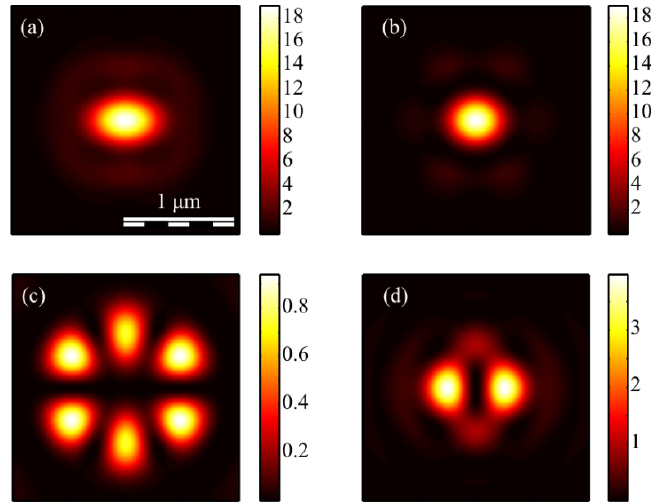
Figure 8. The intensity I ( a ) and its components I x ( b ), I y ( c ) I z ( d ) of the focused vector field (1) of the second ( m = 3) order with a = 3/2.